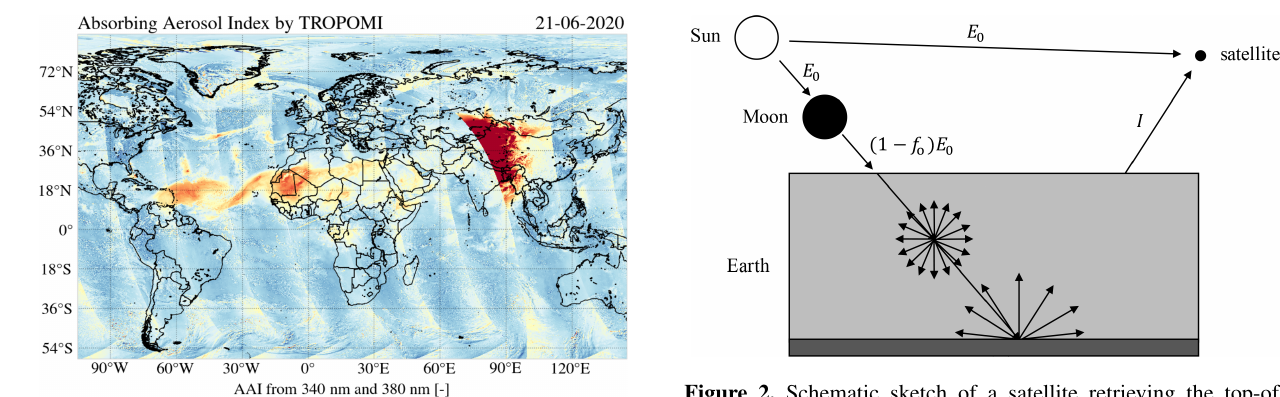
Figure 2. Schematic sketch of a satellite retrieving the top-of- atmosphere reflectance during a solar eclipse. I is the measured ra- diance reflected by the atmosphere–surface system, f o is the eclipse obscuration fraction, and E 0 is the uneclipsed solar